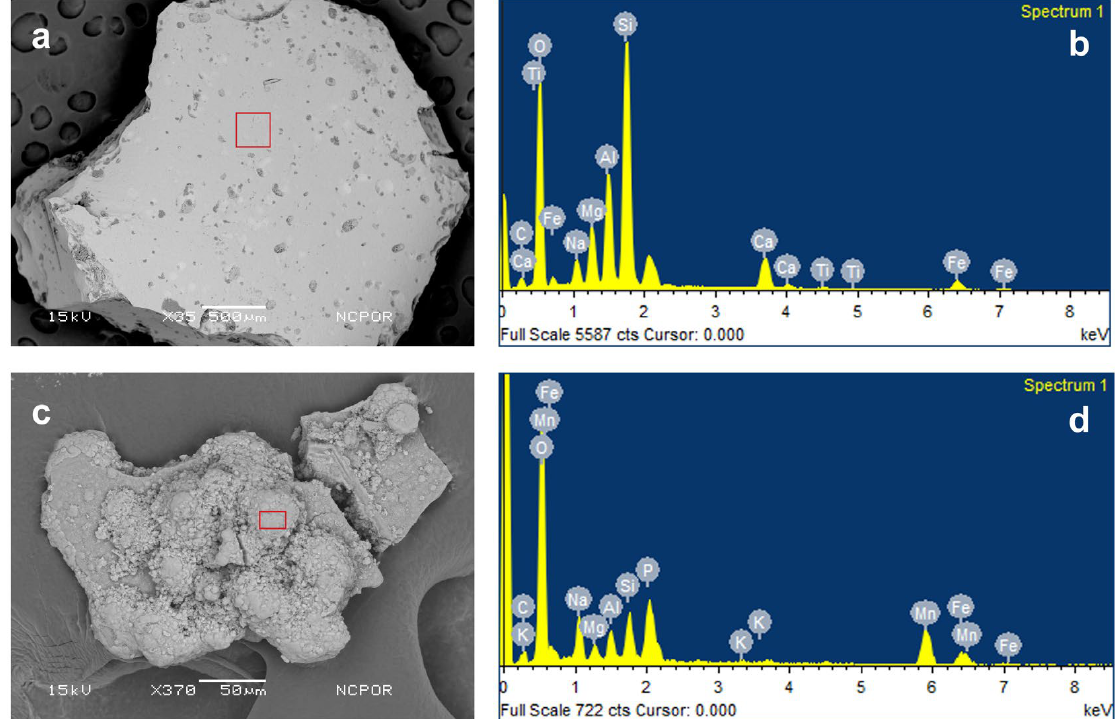
Figure 3. SEM image and EDS spectra of sample. ( a ) SEM image of glass shards obtained from the core, ( b ) EDS spectra of the glass shards, ( c ) SEM image of Fe-Mn-Si oxides, and ( d ) EDS spectra of Fe-Mn-Si oxides.